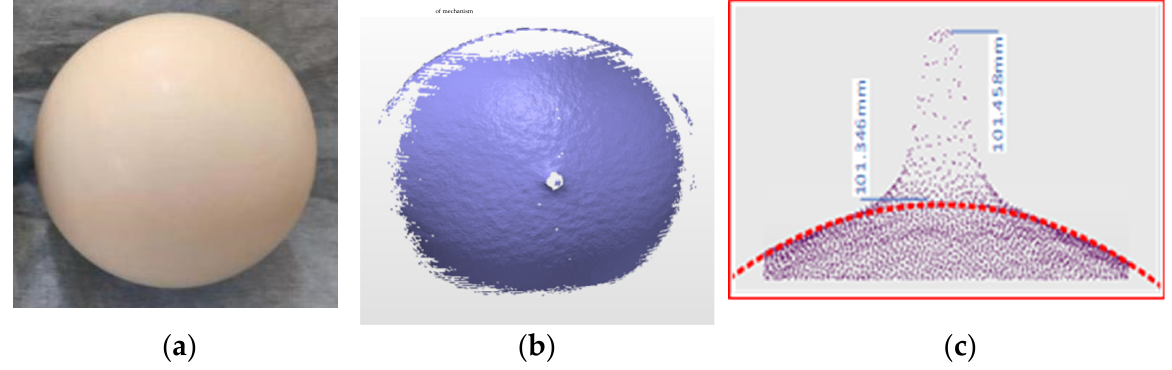
of mechanism Figure 5. ( a ) White ceramic ball with bright surface with reflectance of approximately 90%, ( b ) point cloud data at vertical incidence, and ( c ) close view of the protrusion marked in ( b ). Figure 4b presents the measured results of the black standard ceramic sphere. The point cloud is shown using the best fitting sphere [29]. The fitting condition is that the maximum angle is 45 ◦ . The ratio of eliminating the noise is 5% and the same parameters were further employed in the following scanning tests. In the experiment, 25,298 points are